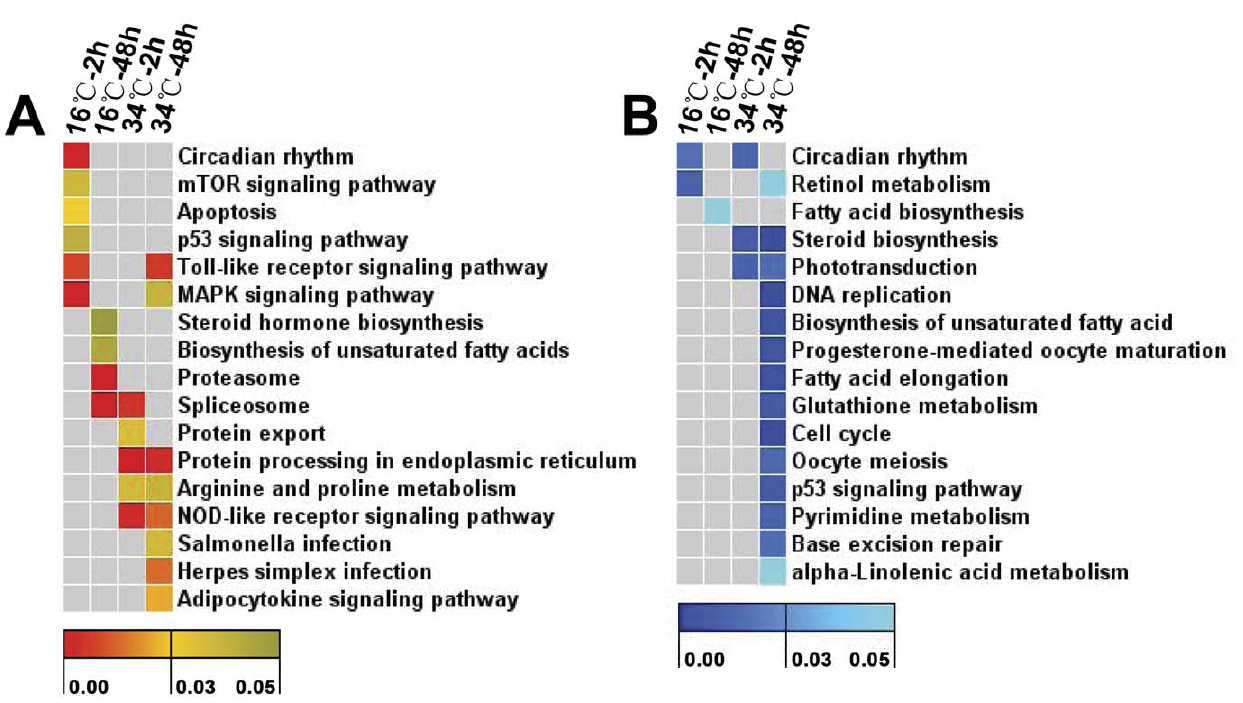
Figure 7. Heat maps of pathway enrichment analysis for temperature-regulated genes. ( A ) Up-regulated genes. ( B ) Down-regulated genes. Genes up or down-regulated by temperature stress at each time point were submitted to pathway enrichment analysis based on KEGG by ClueGO plugin of Cytoscape. Columns and rows in heat maps indicate treatments and enriched pathway terms, respectively. Sample names were displayed above the heat maps. Color scales represent p values of enrichment tests and gray cells indicate an empty value or a value . 0.05.